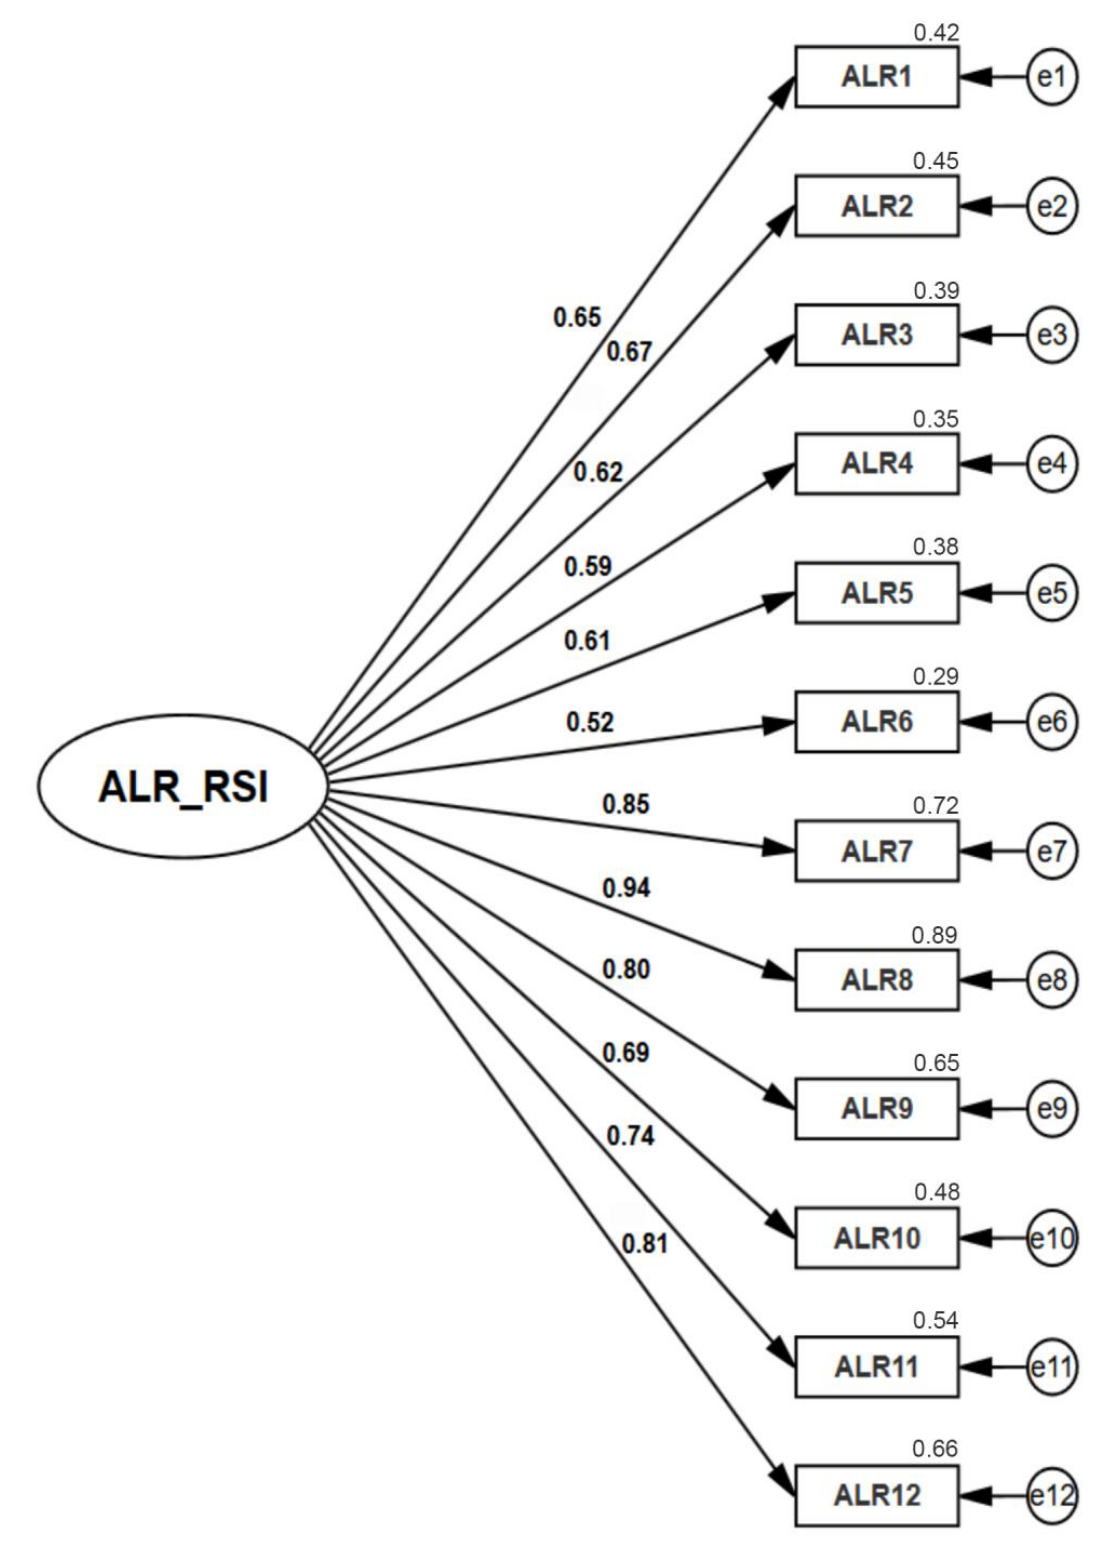
Figure 1. Confirmatory factor analysis (CFA).